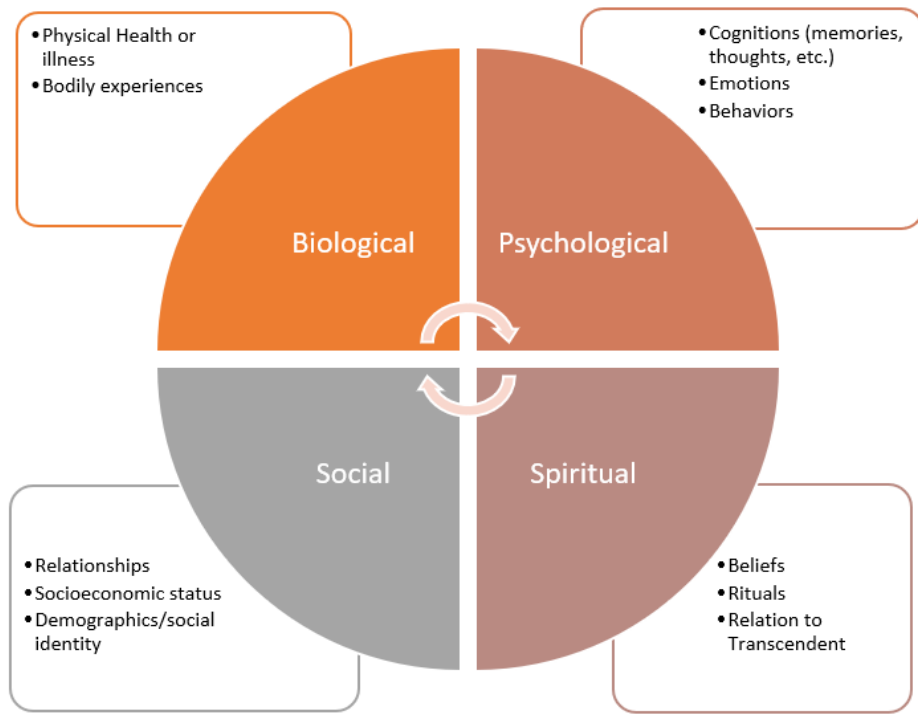
Figure 1. Whole person care seeks to address each facet of the person. Mindfulness and Healthcare